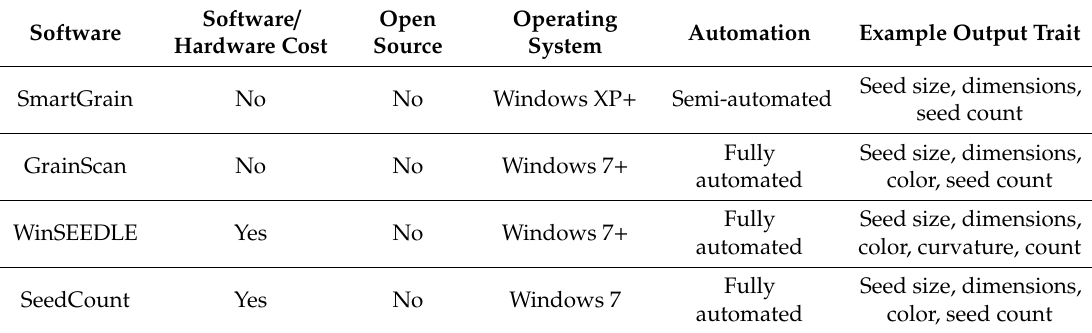
Table 3. Commonly used image-based tools for seed phenotyping in